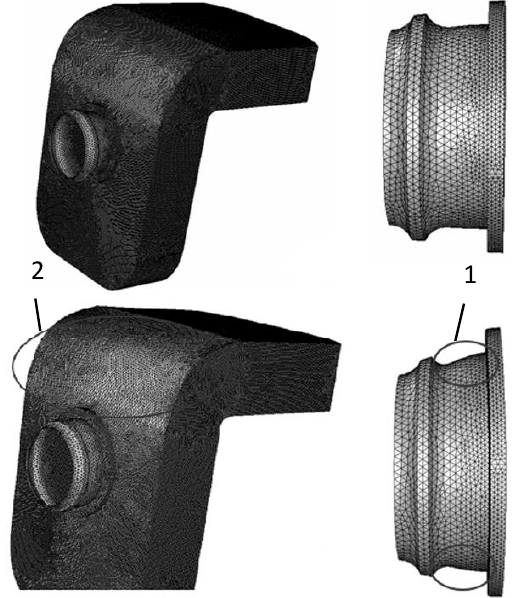
Fig. 8. Deformation: unmodified geometry (Top), modified geometry (Bottom)